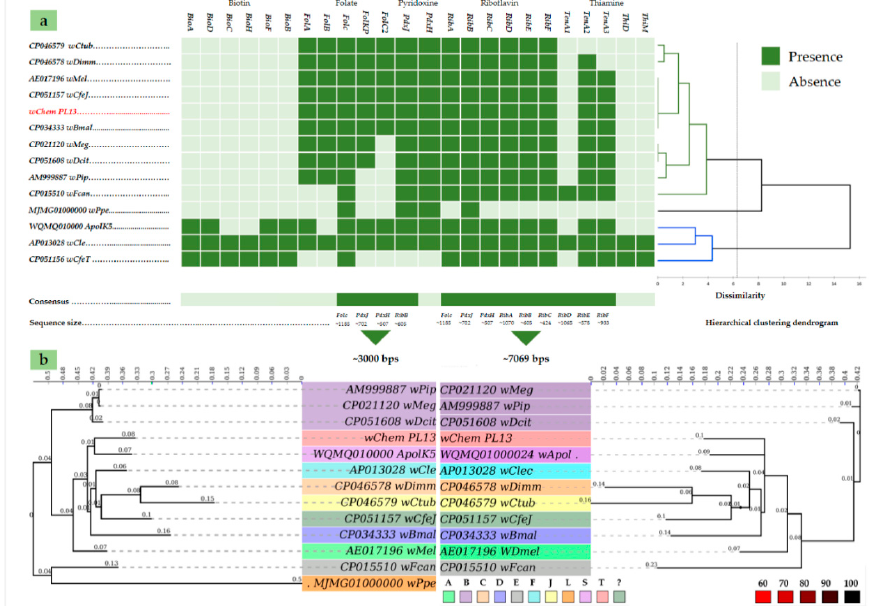
Figure 4. ( a ). Comparative analysis of B-vitamins biosynthesis pathways of the wChem PL13 strain and the other Wolbachia strains. a. Matrix based on the presence / absence of B-vitamins biosynthesis genes from the wChem PL13 and the other Wolbachia strains. The matrix was organized according to the hierarchical clustering (AHC) of B-vitamins profile among Wolbachia strains (left cladogram). ( b ).Maximumlikelihoodphylogeniesbasedon3000bps(rightphylogram)and7069bps(leftphylogram) using respectively K81uf ( + G) [44] and GTR ( + G) [45] substitution models. Likelihoods values were − 16949.78 and − 36573.10 respectively. Values above branches indicate the length of each branch’s, while the axis showed the global distance observed throughout the trees. Color codes indicating the Wolbachia supergroup (label) and the bootstraps percent’s